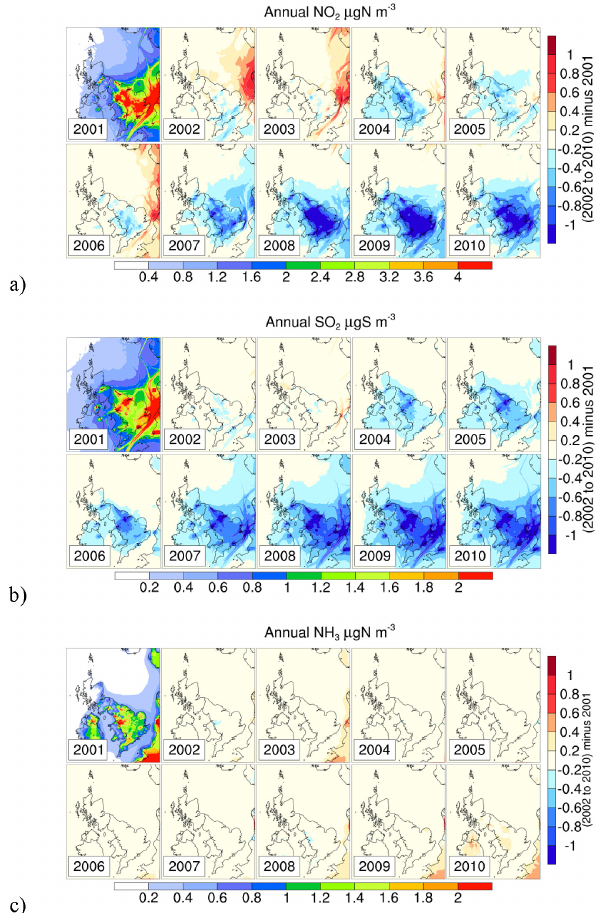
Figure 5. Modelled annual average surface concentrations of (a) NO − , (b) SO 2 − and (c) NH + . The top left panel of each figure 3 4 4 shows the concentrations in 2001 (horizontal scales in µgNm − 3 or µgSm − 3 , as relevant). The remaining panels illustrate the dif- ference in surface concentrations in each of years 2002 to 2010 compared with 2001 (vertical scales in µgNm − 3 or µgSm − 3 , as